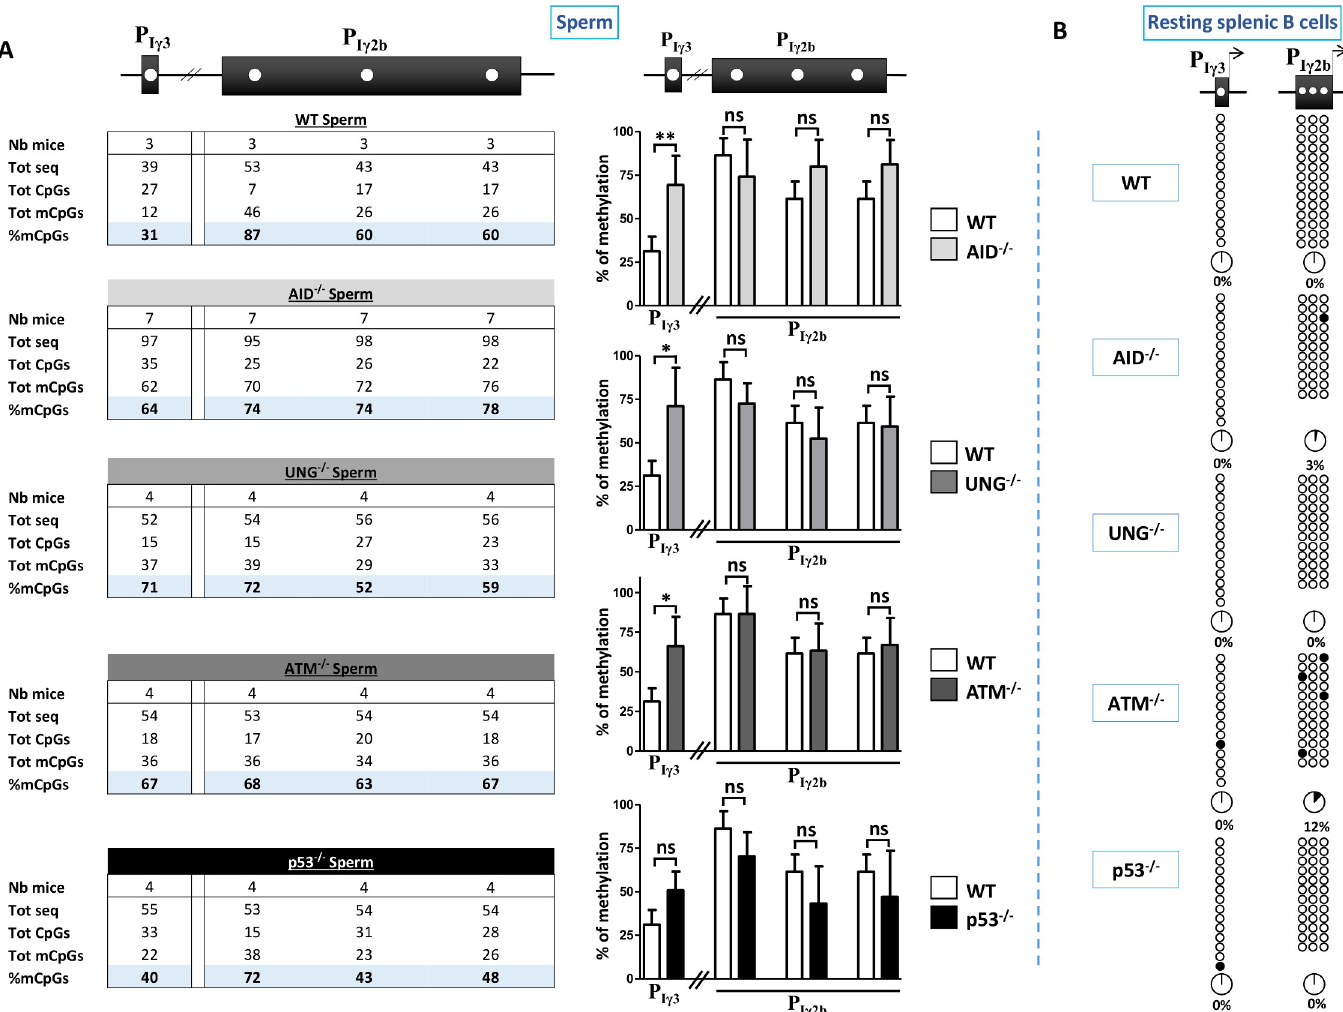
Fig 5. Pathways involved in the demethylation of I γ 3 promoter. (A) The table on the left summarizes the results of bisulphite sequencing of the CpGs analyzed (upper scheme) in sperm of WT adult males or with the indicated deficiencies. For each genotype, the number of mice, the total number of sequences, of demethylated CpGs (CpGs), of methylated CpGs (mCpGs), and the percentages of mCpGs (highlighted), are indicated. The histograms on the right show the statistical data for each individual CpG displayed on the upper scheme. The differences observed between WT and mutant mice were evaluated by unpaired t-test. The difference between means is significant if p < 0.05 ( � ), very significant if p < 0.01 ( �� ); ns, not significant. (B) Methylation patterns of I γ 3 and I γ 2b promoters in resting splenic B cells with the indicated genotypes.